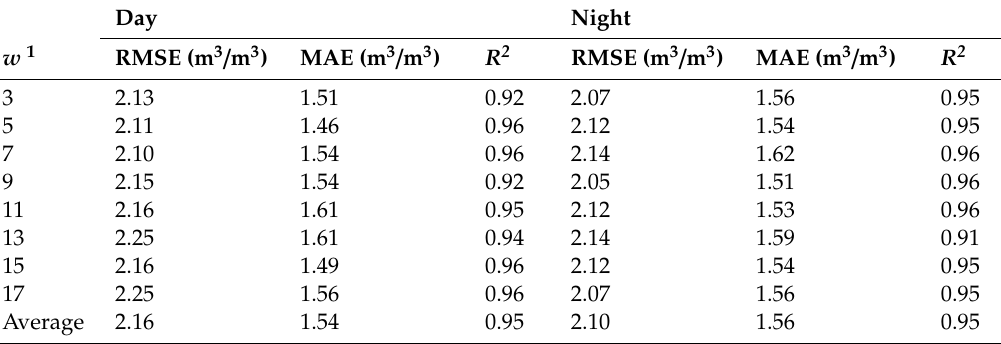
Table 2. The mean RMSE, MAE, and R 2 values between the corrected values of variable z and explanatory variables (original value) in the time series reconstruction of the di ff erence decomposition (TSRDD) for di ff erent window